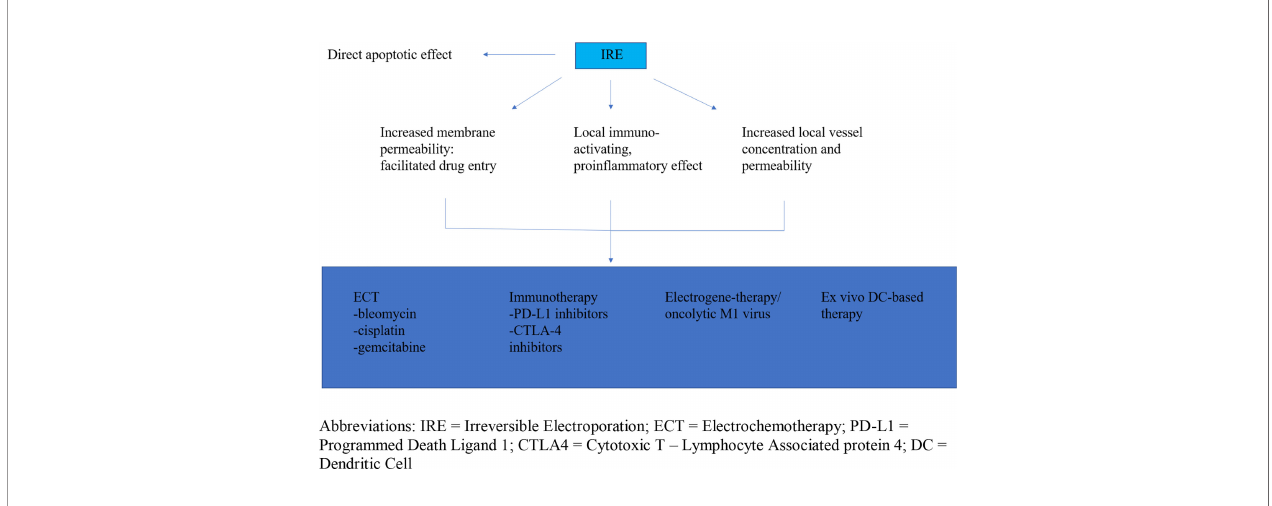
FIGURE 1 | Irreversible electroporation anti-tumor effect and facilitation of drug mechanism and delivery. IRE, Irreversible Electroporation; ECT, Electrochemotherapy; PD-L1, Programmed Death Ligand 1; CTLA4, Cytotoxic T – Lymphocyte Associated protein 4; DC, Dendritic